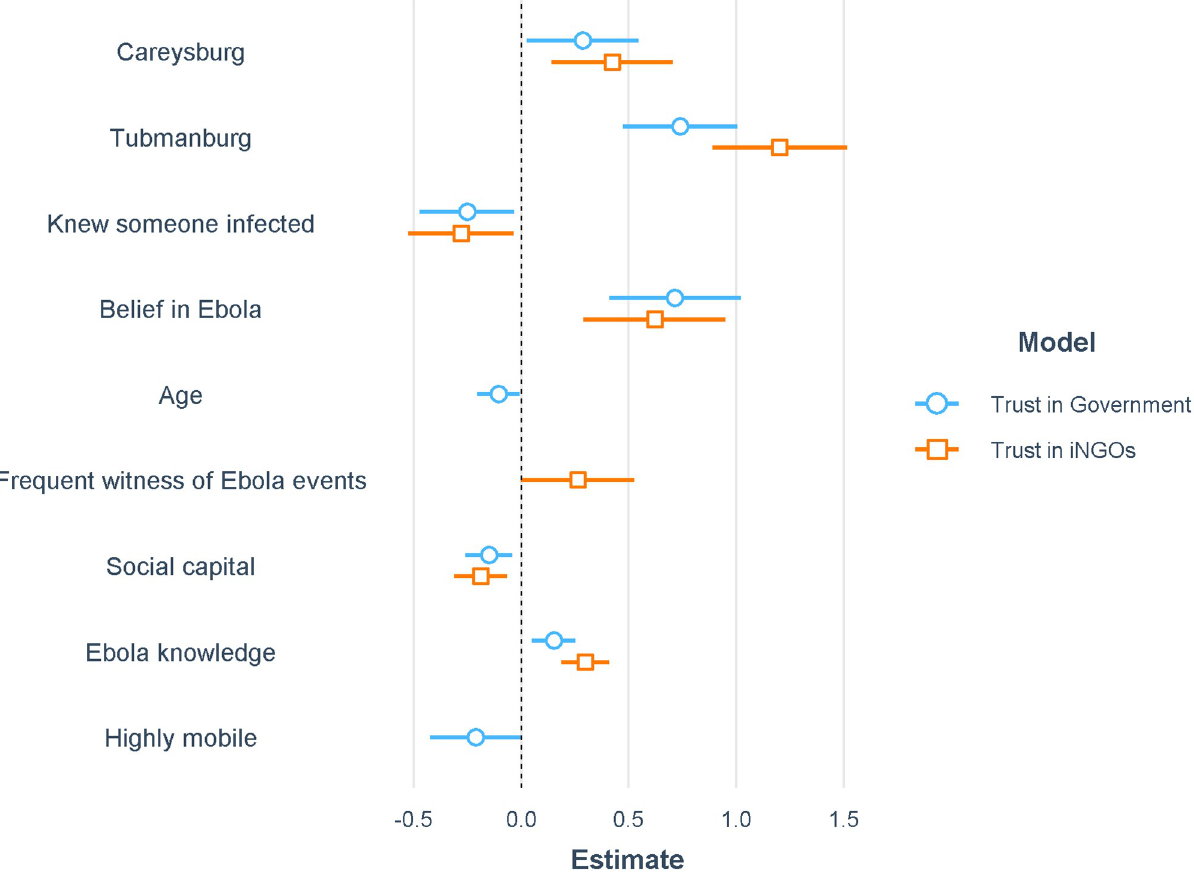
Fig 3. Generalized linear model regression coefficient estimates for trust in government and trust in iNGOs as dependent variables in time period 3 using an ordinal regression model. Some independent variables were dropped via AIC stepwise reduction from one or both models. A negative coefficient indicates a negative association with trust, while a positive coefficient indicates a positive association with trust. Community descriptions: Careysburg = rural, low exposure; Tubmanburg = urban, high incidence.